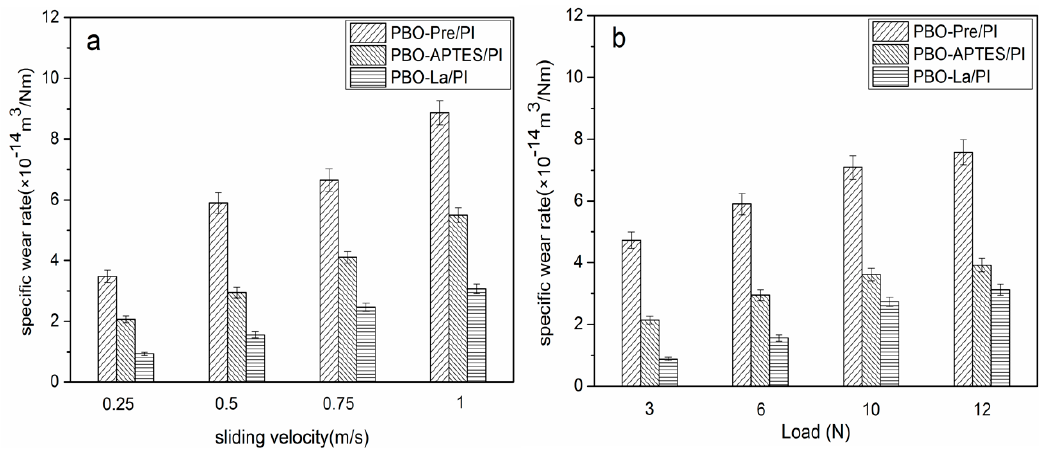
Figure 11. The specific wear rate of PI composites in a 130 °C environment as a function of ( a ) sliding velocity (load: 6 N) and ( b ) load (velocity: 0.5 m/s).